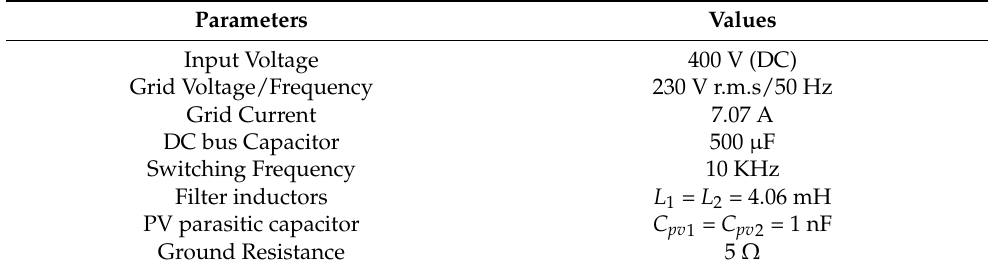
Table 1. Parameters of the simulation model.